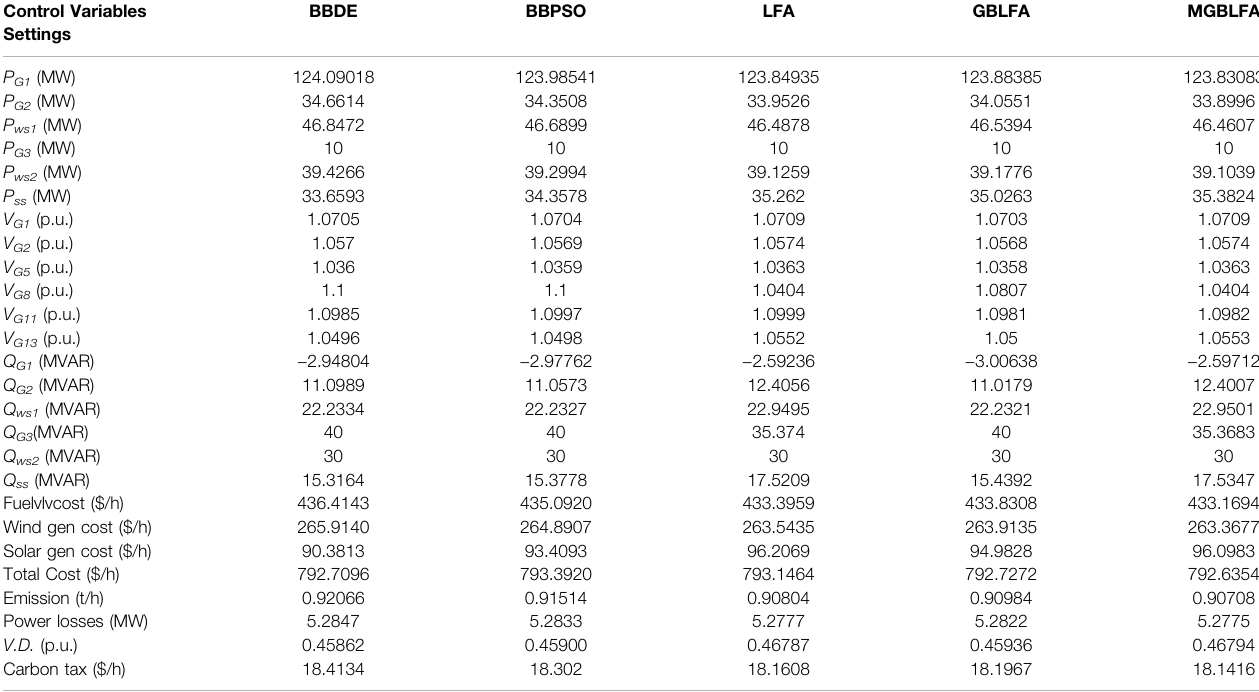
TABLE 12 | The variables optimal values obtained by algorithms for Case 10. Control Variables Settings